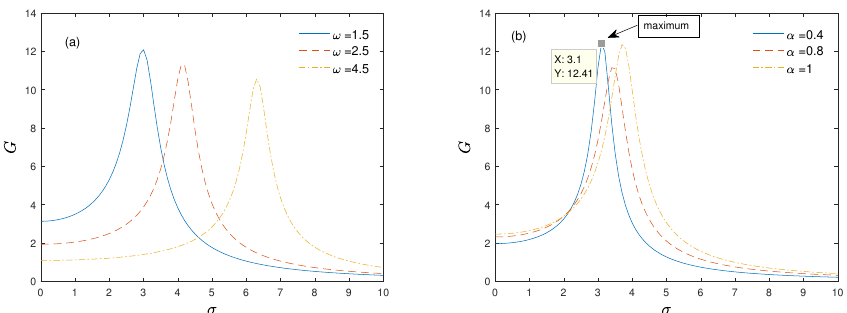
Figure 3. The output gain G as function of σ under different values of ω and α . The common parameters are set as Ω = 0.1 π and λ = 5, and the other parameters are ( a ) α = 0.9 and ( b ) ω = 2.